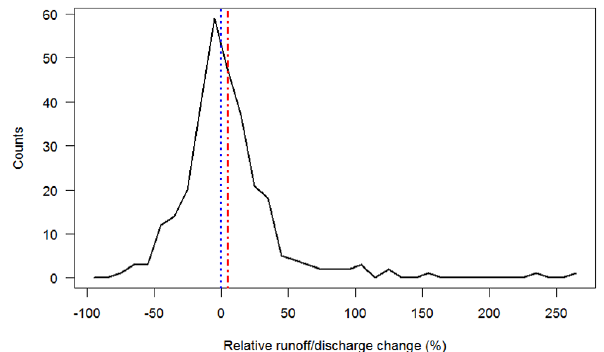
Figure 2. Runoff change ( x axis, %) in WA based on all cases in the database (i.e., including different time period, rivers and models). The blue dashed line represents the median of the distribution; the red one is the mean. We focus here only on the impact of climate change: this is the only changing parameter (no water use or land use